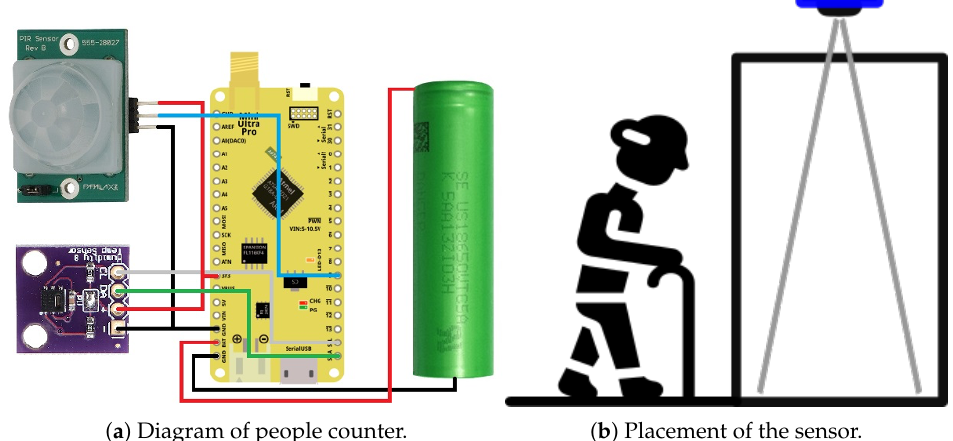
Figure 4. People counter diagrams.